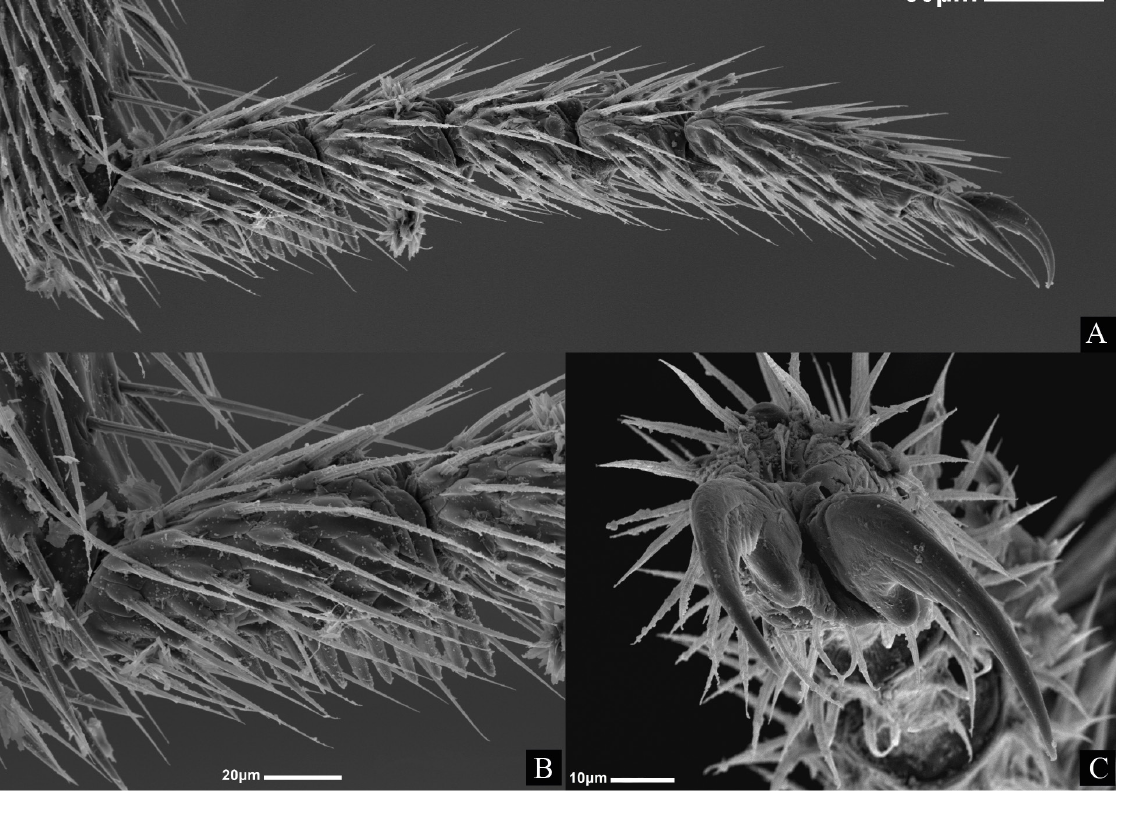
Fig. 3. Iviephengus ferreirai gen. et sp. nov., paratype, ♂ (DZRJ). Scanning electron